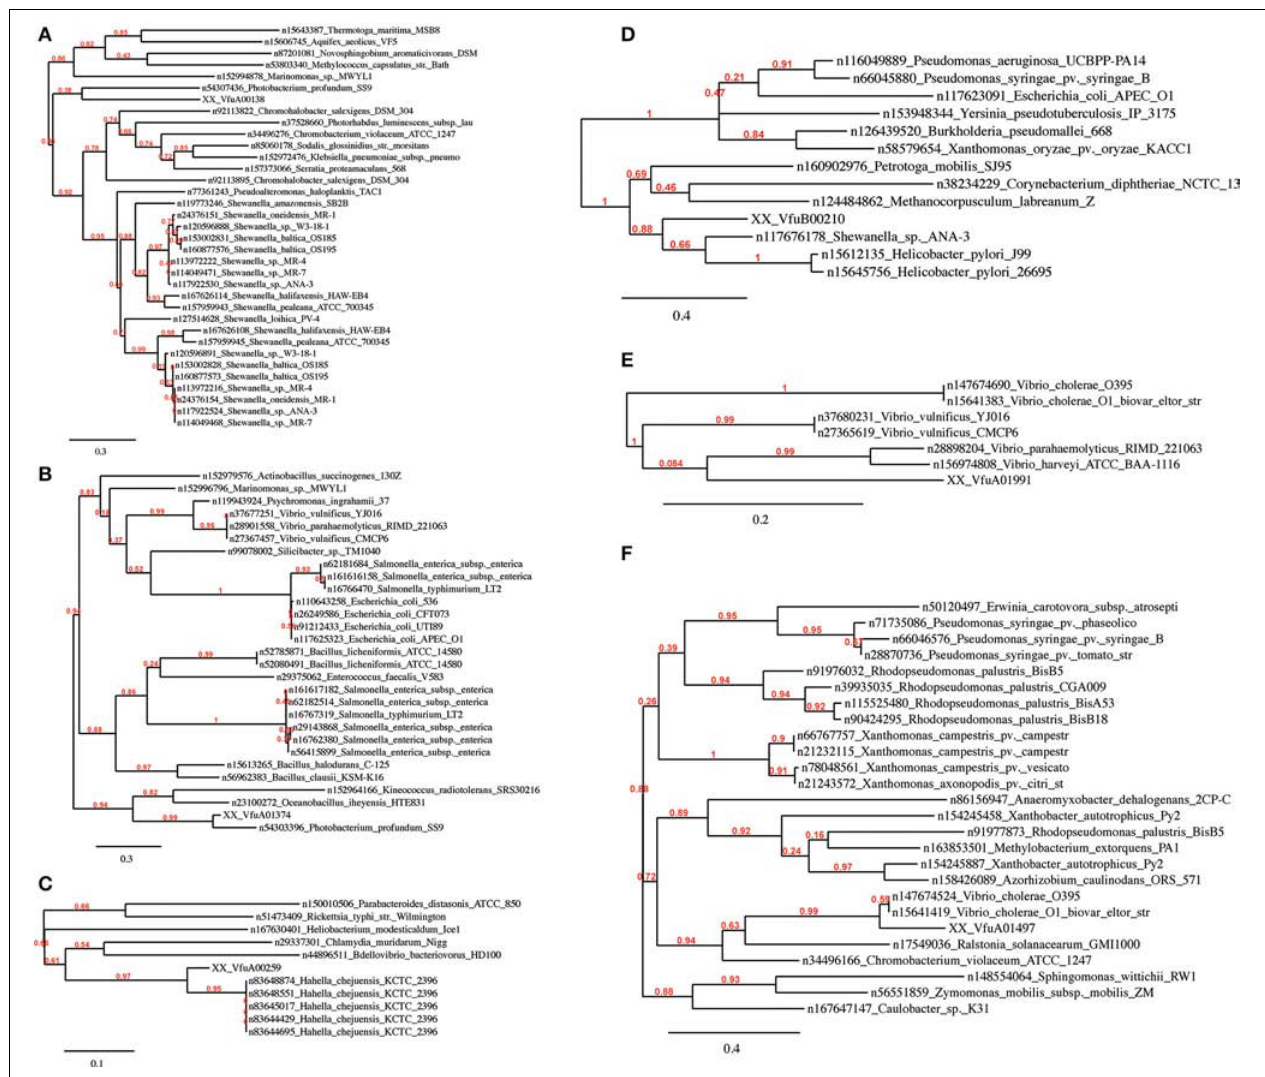
FIGURE 5 | Phylogenetic trees of the V. furnissii proteins (A) VfuA00138, (B) VfuA01374, (C) VfuA00259, (D) VfuB00210, (E) VfuA01991, and (F) VfuA01497 showing putative horizontal gene transfer events. Numbers representing branch support